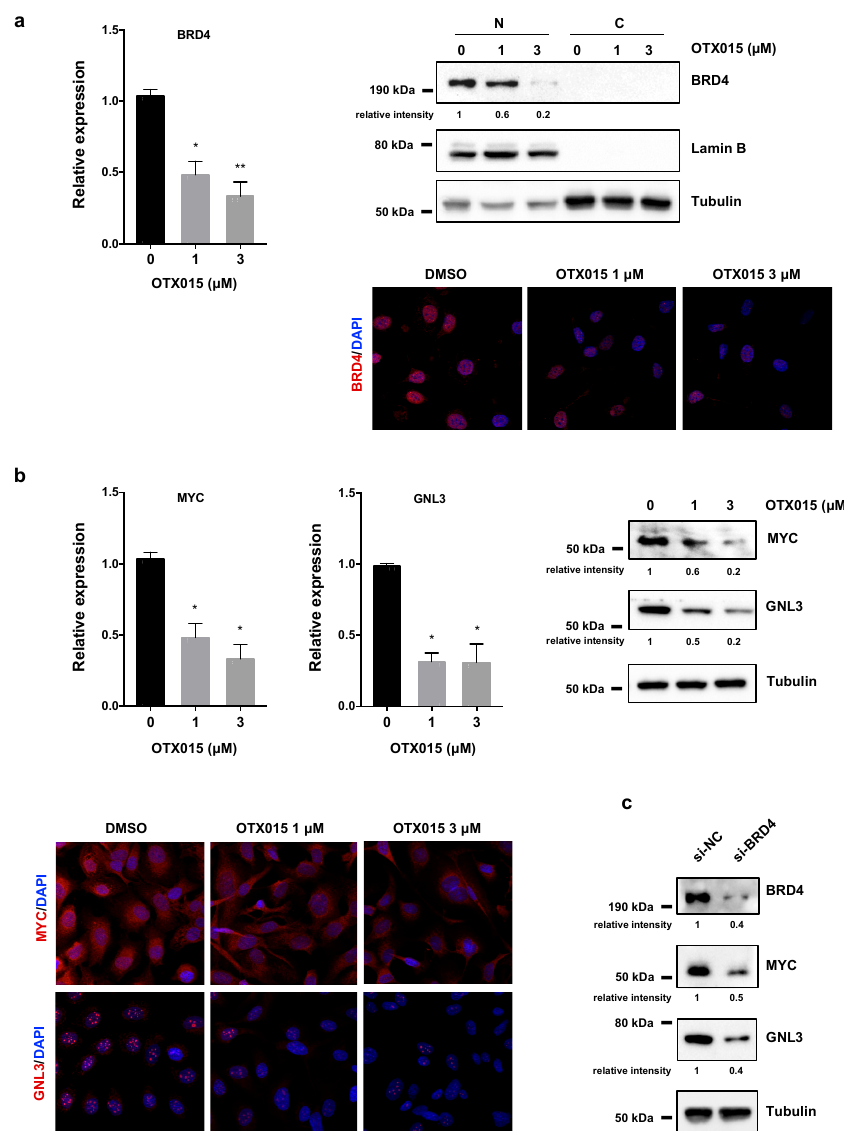
Figure 4. Effects of OTX015 on BRD4, MYC and GNL3 expression in OC cells. ( a ) Experiments of q-PCR (left panel) showing BRD4 mRNA levels in OTX015-exposed SKOV3 cells (0–1–3 µ M), expressed as fold change relative to control cells, set at 1. β -actin mRNA was used as endogenous control. Histograms indicate mean values ± SD of two independent experiments, each performed in triplicate. Statistical significances were calculated by one-way ANOVA (* p < 0.05; ** p < 0.01). WB analysis (upper right panel) performed on nuclear (N) and cytoplasmic (C) protein extracts from OTX015-exposed SKOV3 cells (0–1–3 µ M) for 72 h. Lamin B served to normalize nuclear fraction, whilst tubulin was used for the cytoplasmic fraction. IF experiments (lower right panel) showing the reduction of BRD4 nuclear staining (red) in OTX015 treated (1 µ M and 3 µ M) cells respect to DMSO controls. DAPI (blue) for nuclear staining. Representative images captured under ApoTome microscope at 40 × magnification. ( b ) q-PCR analysis (left panel) of MYC and GNL3 expression in OTX015-exposed SKOV3 cells (0–1–3 µ M), each expressed as fold change relative to mocked control cells, set at 1. β -actin mRNA was used as endogenous control. Histograms indicate mean values ± SD of two independent experiments, each performed in triplicate. Statistical significances were calculated by one-way ANOVA (* p < 0.05 vs. mocked control). WB analysis (right panel) performed on total protein extracts from SKOV3 cells treated with OTX015 (0–1–3 µ M) for 72 h. Tubulin served as loading control and representative blot was shown. IF experiments (lower left panel) showing the downregulation of MYC expression and the lower intensity of GNL3 nucleolar foci in OTX015 treated (1 µ M and 3 µ M) cells in comparison to DMSO controls. ( c ) WB analysis of BRD4, MYC and GNL3 proteins performed on total protein extracts from SKOV3 cells transfected for 72 h with BRD4 siRNAs (si-BRD4) or negative control molecules (si-NC). Tubulin served as loading control and representative blot was shown. The original Western Blot images can be found in Figure